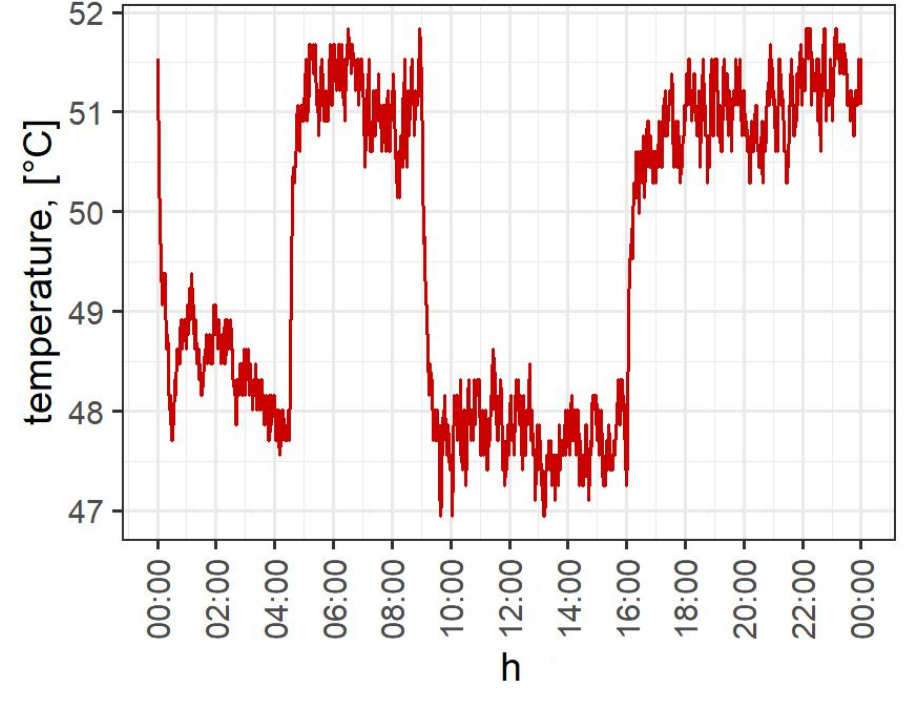
Figure 6. The course of domestic hot water temperature on a working day—power supplied from a heating